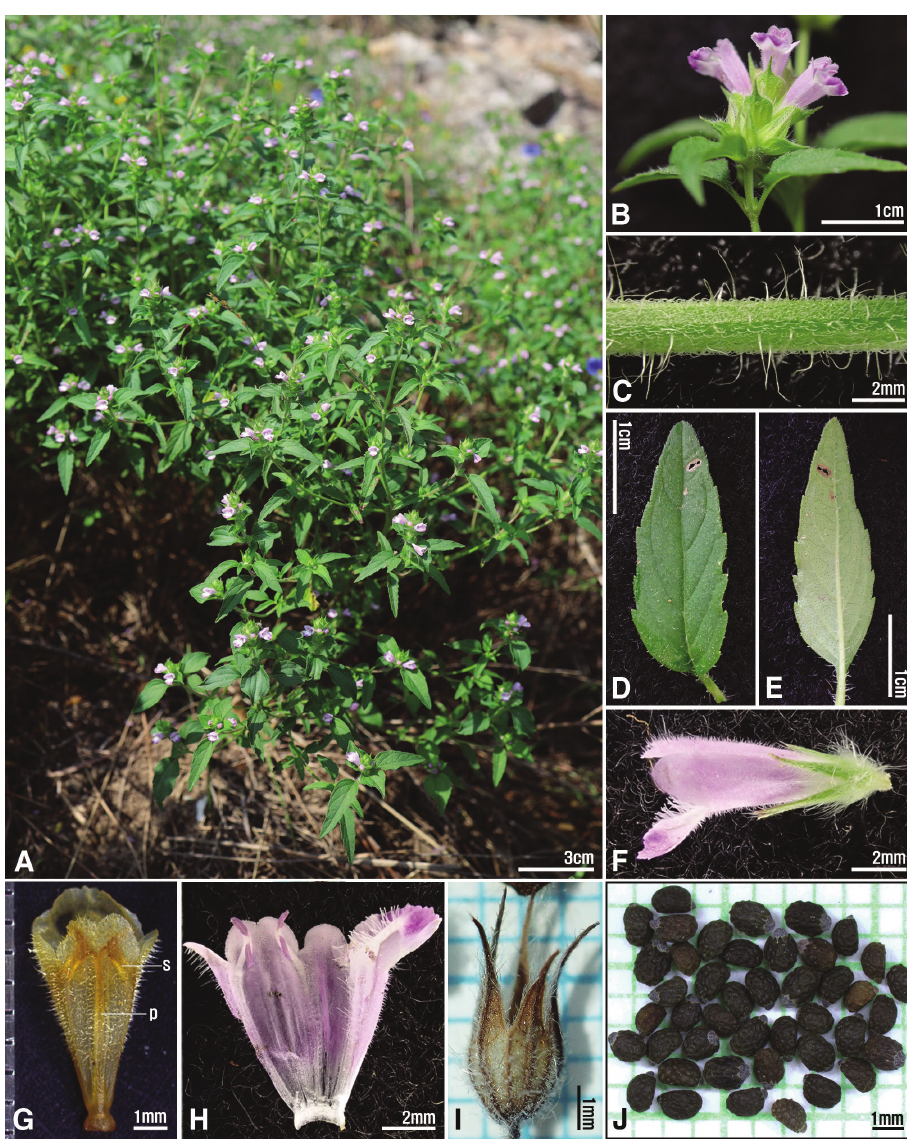
Figure 1. Mosla dadoensis A habit B raceme C stem D, E leaf ( D adaxial E abaxial) F flower G, H corolla ( S stamen P pistil) I calyx J seed. Photos from H.J.Choi 210923-001 ( A–H ) and H.J.Choi 211025-001 ( I, J